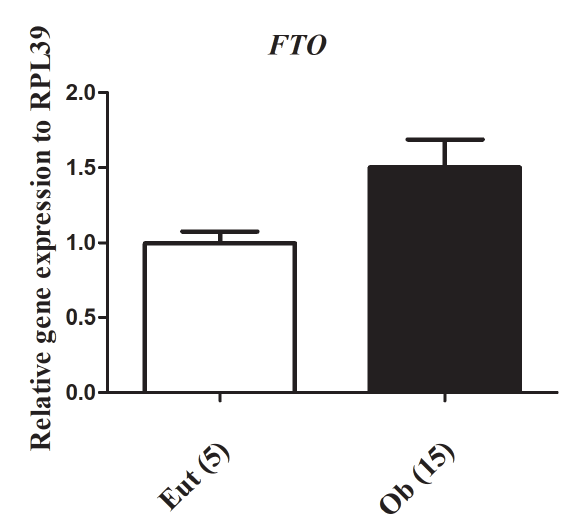
Figure 1. FTO (normalized to RPL39) gene expression profile in eutrophic and overweight/obesity individuals. The graphic is presented as mean ± standard deviation; p 0.14. Eut, eutrophic; Ob, overweight/obesity.